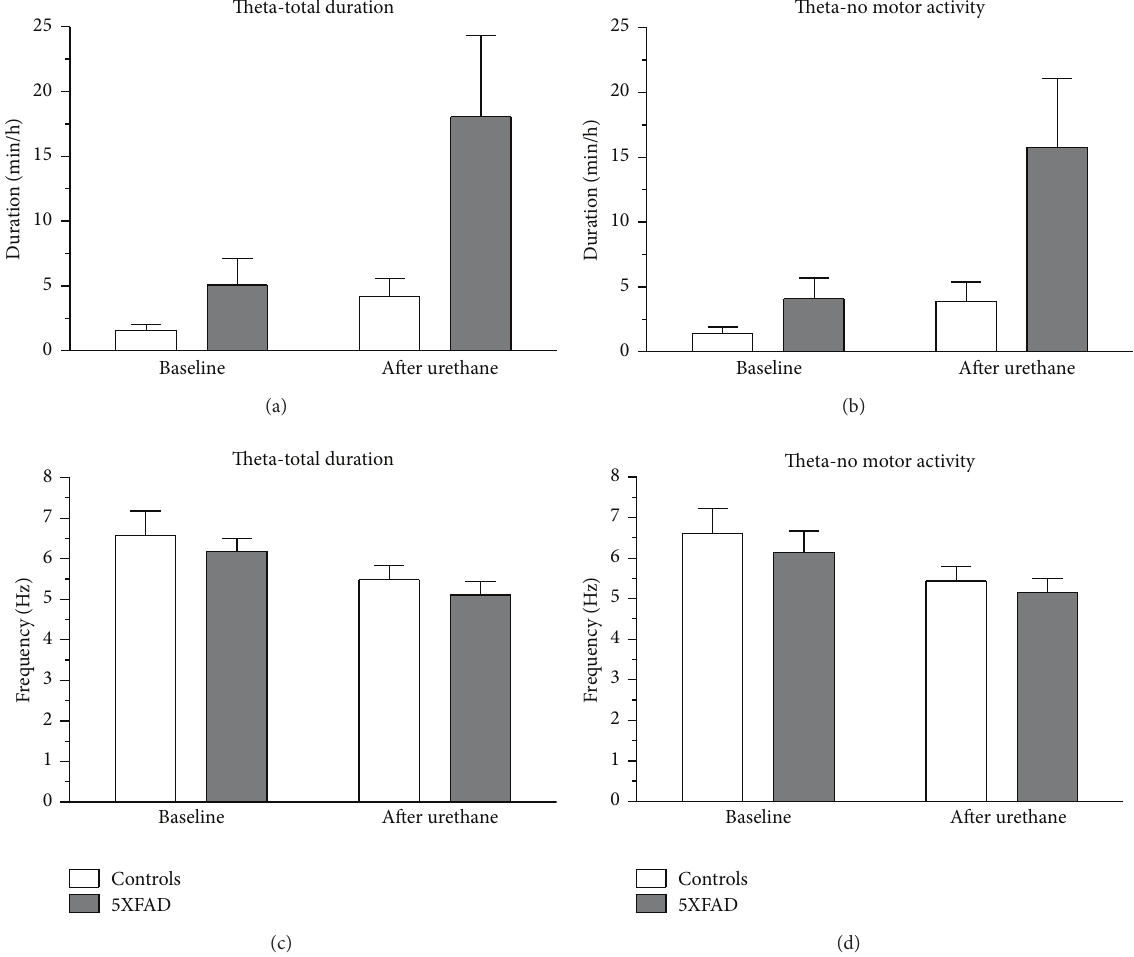
Figure 9: Urethane induced hippocampal theta oscillations in control and 5XFAD mice. CA1 hippocampal theta recordings from both genotypes were analyzed for duration of atropine-sensitive type II theta oscillations regarding total observation period (a) and nonmotor episodes (b). In addition, theta frequency was calculated for total duration (c) and nonmotor episodes